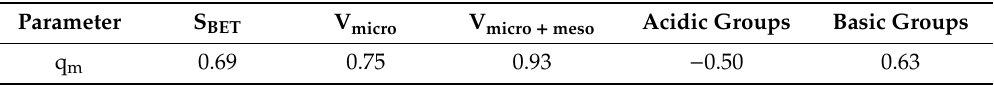
Table 10. Pearson correlation coe ffi cients.